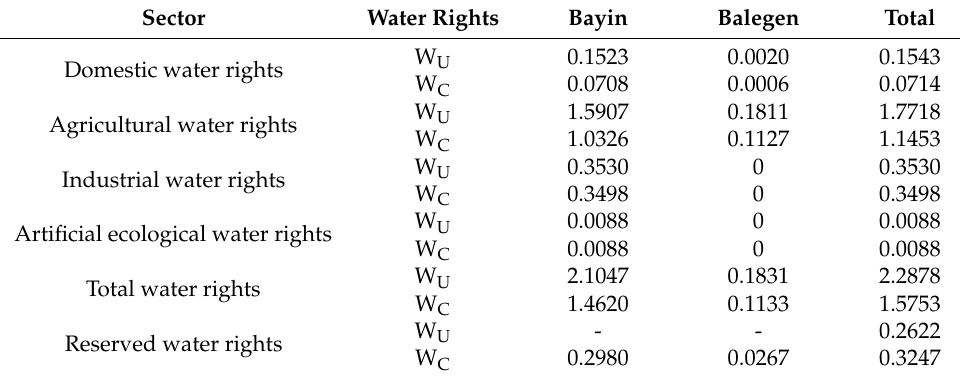
Table 2. Water rights confirmation for Delingha